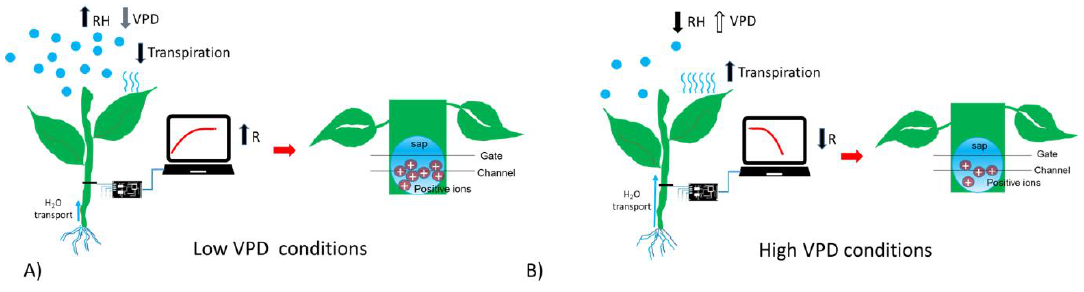
Figure 4. Scheme reporting the sensor response (R) in ( A ) low VPD conditions; ( B ) high VPD conditions.